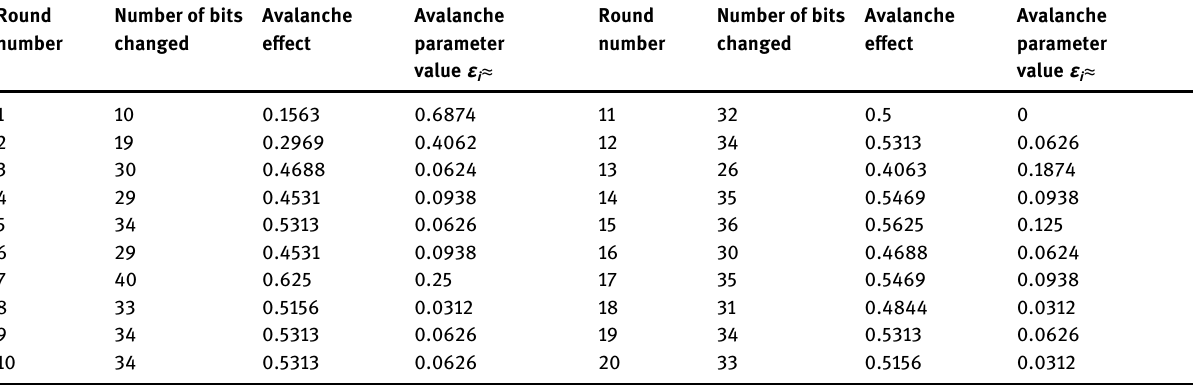
Table 4: Results of the study of the avalanche e ff ect Round number